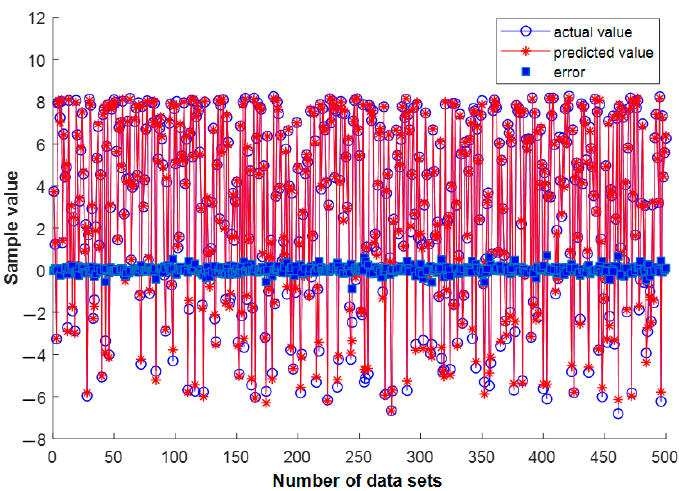
Figure 8. Comparison of predicted value and actual value of BP neural network test set.